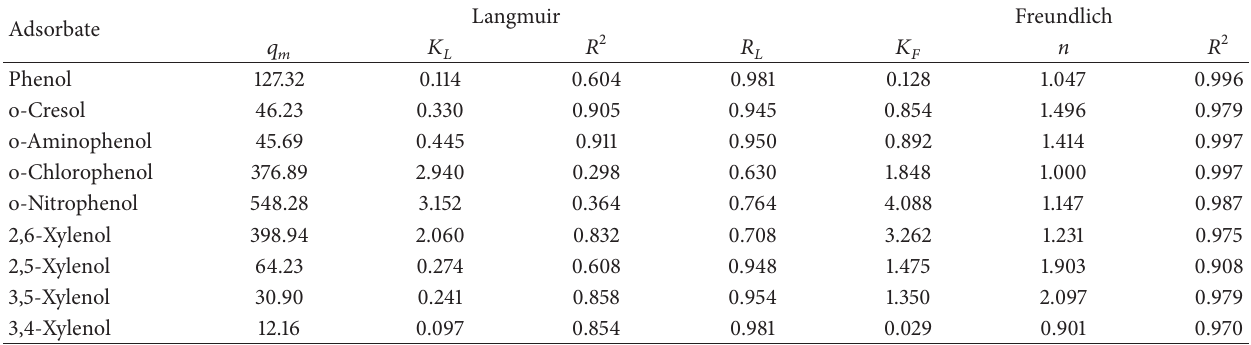
Table 2: Isotherm constants and regression data for Langmuir and Freundlich adsorption isotherms for adsorption of substituted phenols on asphaltene from aqueous solutions.